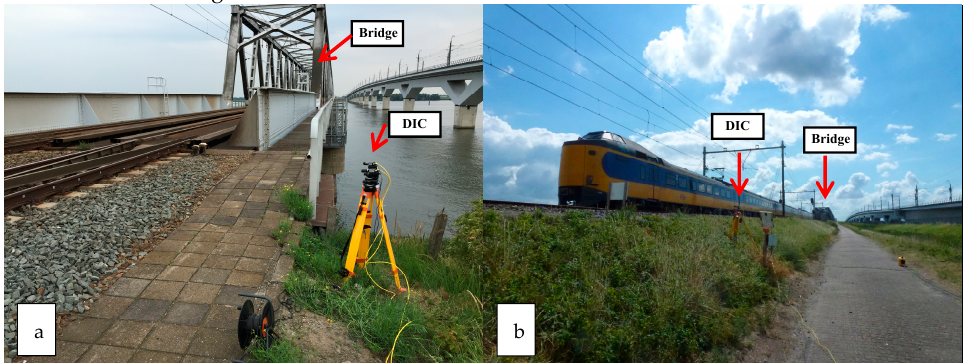
Figure 9. Measuring locations of the dynamic displacements of rail are measured by the DIC device: ( a ) the location close to the bridge, ( b ) the location far from the bridge.